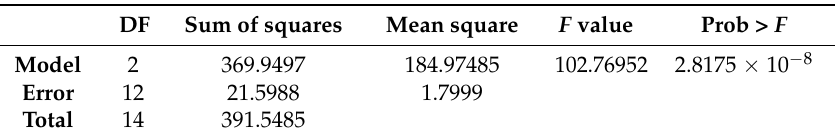
Table 7. Overall analysis of variance of elongation.